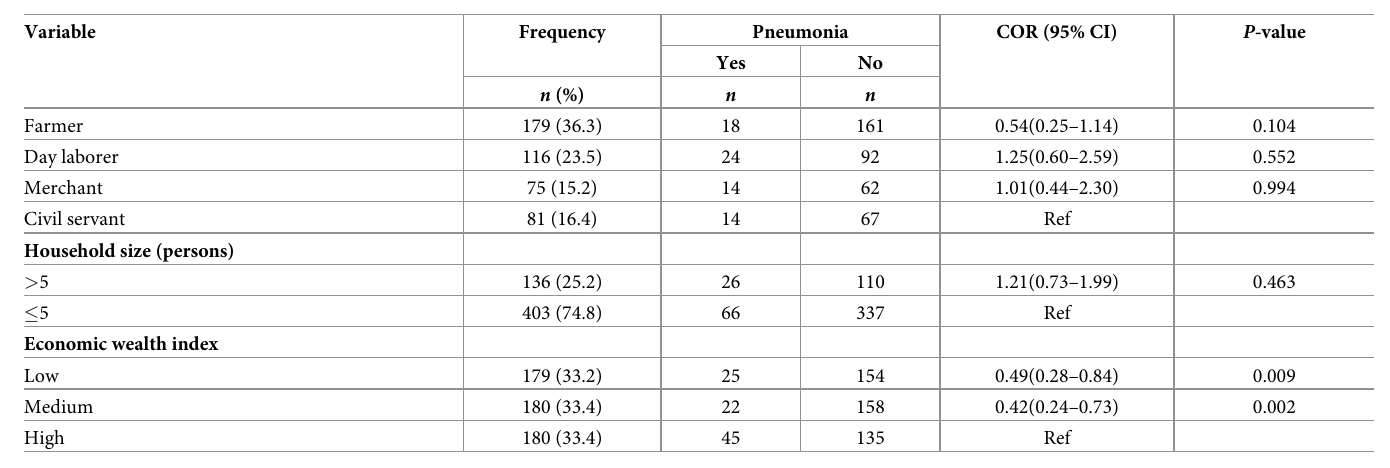
family history of ARI. The odds of developing childhood pneumonia were 2.43 times higher in children with acute malnutrition than in children with normal nutritional status (AOR = 2.43; 95%CI: 1.18–5.04) (Table